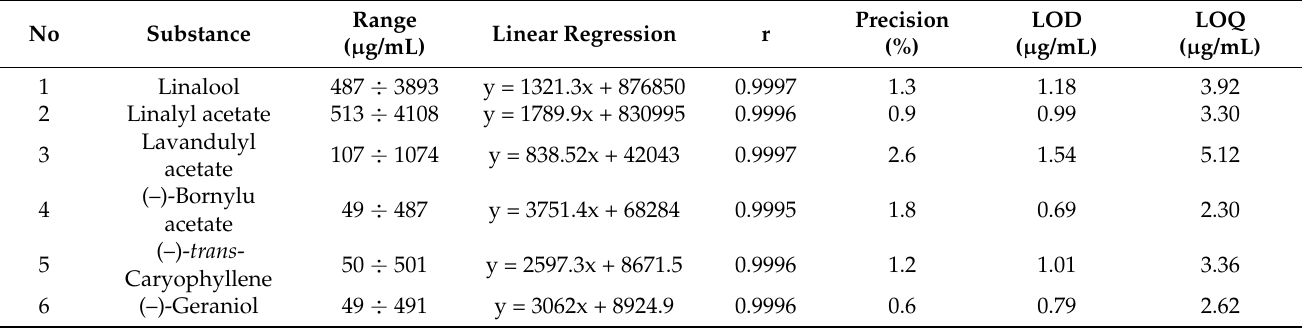
Table 1. Validation parameters for the determination of test substances.